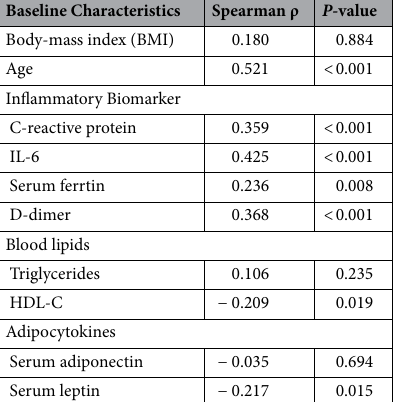
Table 2. Correlation of biomarkers with structural lung impairment at early post-acute follow-up. N = 145. Biomarkers were correlated with the severity of structural lung impairment as assessed by Syngo.via CT Pneumonia Analysis software at 60 days post-COVID